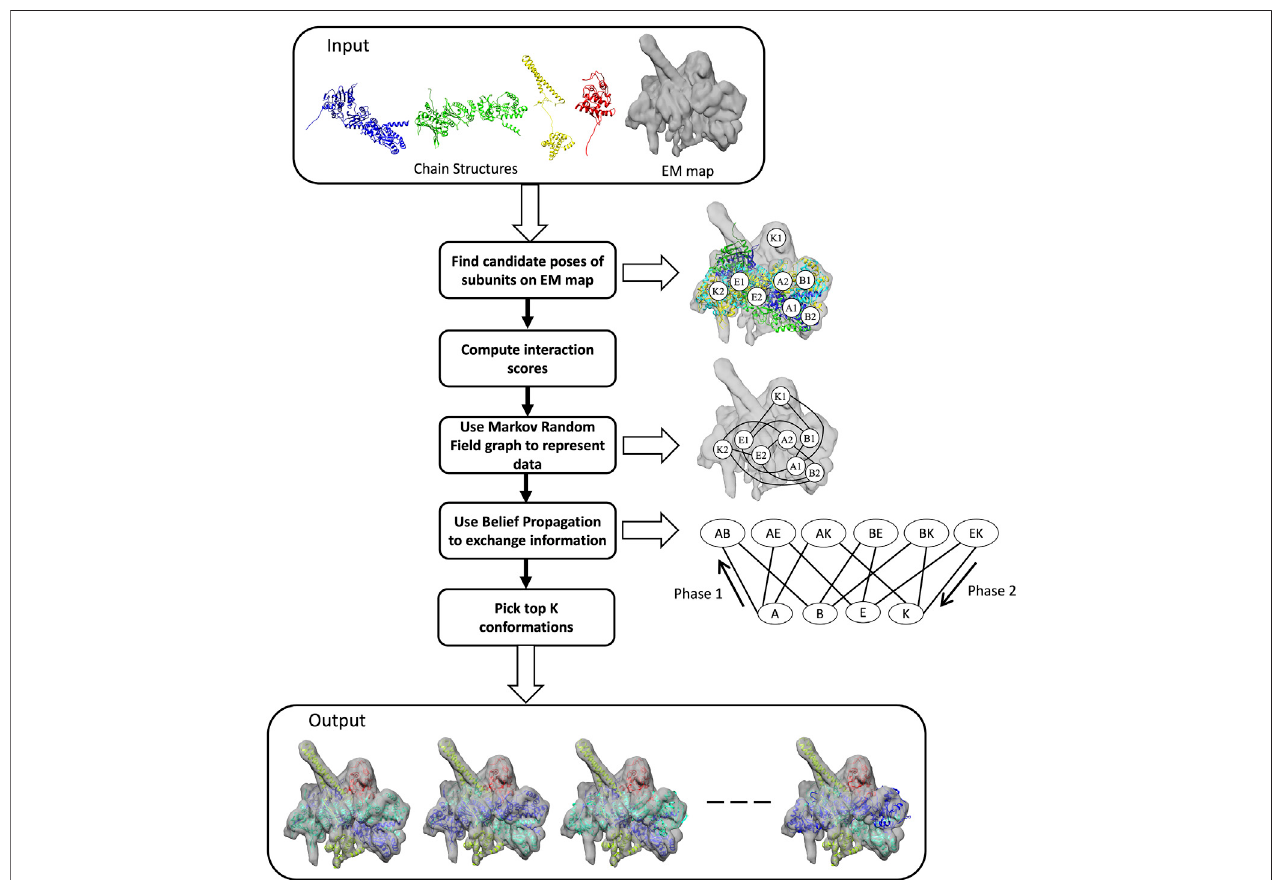
FIGURE 1 | Work fl ow of MarkovFit. The method starts by searching the conformational space for potential positions of each subunit and computes scores which quantify the goodness-of- fi t between each subunit and the cryo-EM map, and the interactions between the subunits. The right panel shows some candidate poses of subunitsA,B,E,andK,whichareA1,A2,B1,B2,E1,E2,K1,andK2.Subsequently,subunitsandtheirinteractionsarerepresentedusingaMarkovrandom fi eld(MRF) graph.MRFnodesexchangeinformationusingabeliefpropagationalgorithm.Thegraphatthebottomoftherightpanelshowssinglenodes,eachrepresentingthe candidate poses of a subunit, and interaction/pairwise nodes, each representing the interactions between candidate poses of a pair of subunits. The last step is extracting the top conformations using a max-heap tree.